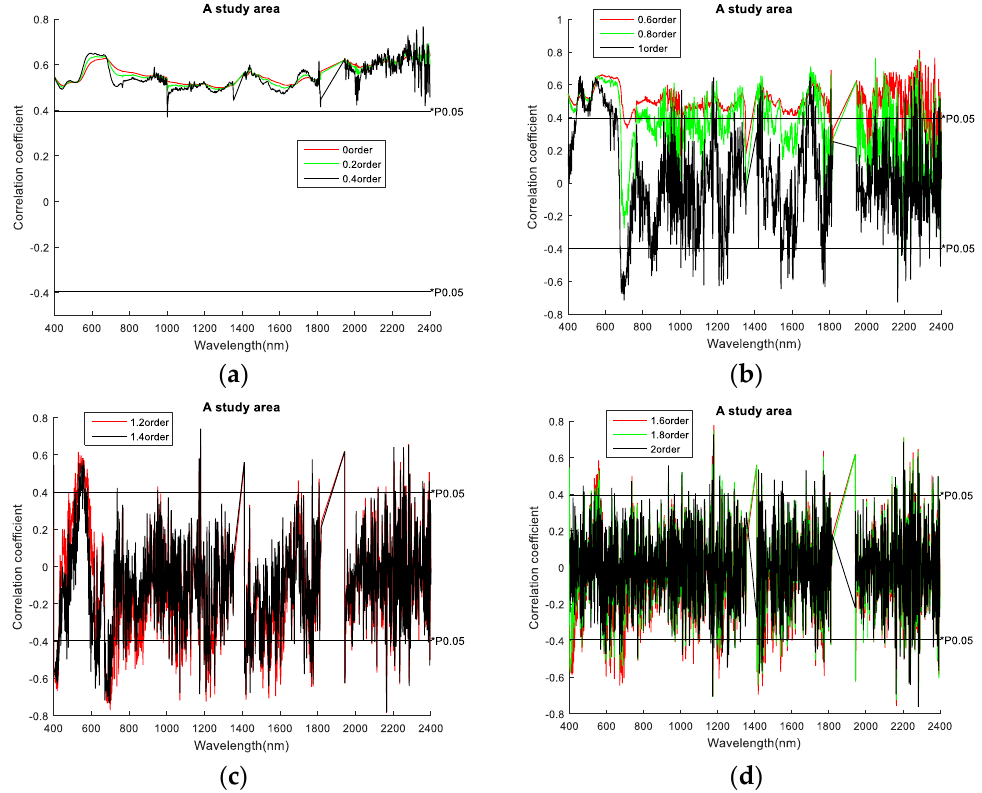
Figure 2. Correlation coefficients between available phosphorus content and soil spectrum with orders: ( a ) 0 – 0.4; ( b ) 0.6 – 1; ( c ) 1.2 – 1.4; ( d ) 1.6 – 2.